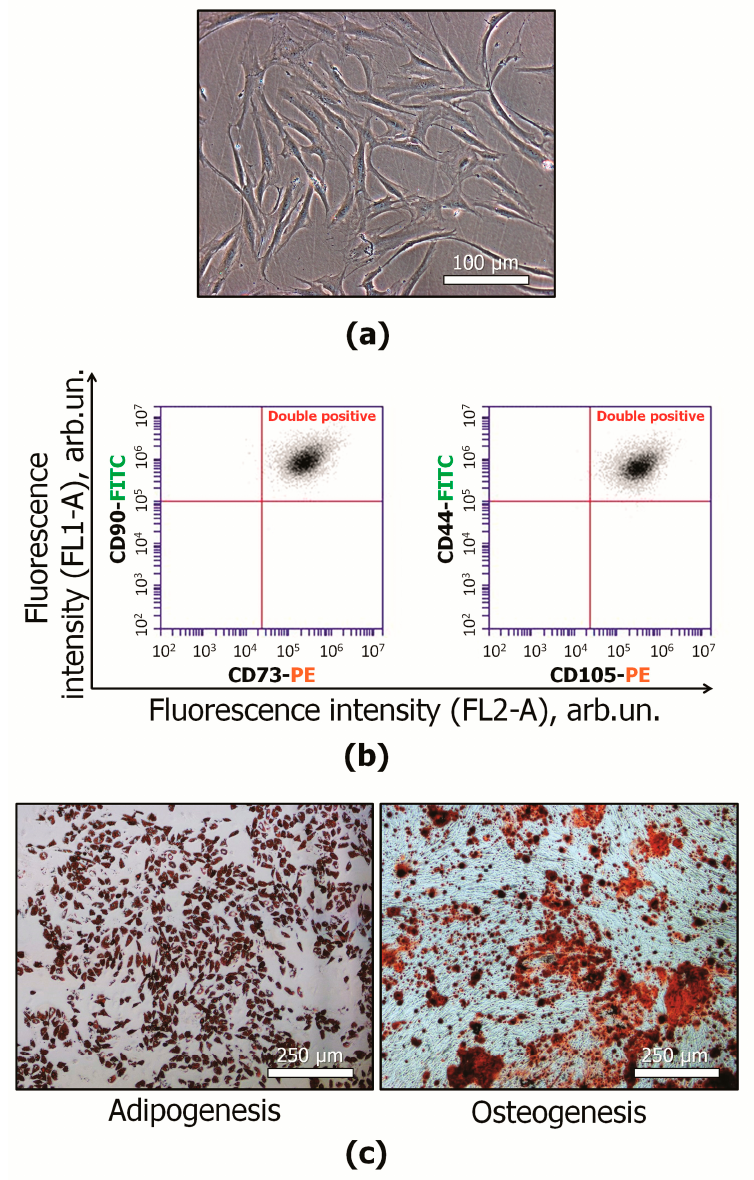
Figure 1. Characterization of MSCs: ( a ) representative image of MSCs in vitro, light microscopy (phase contrast); ( b ) representative flow cytometric plots of immunophenotype. MSCs were stained with antigen specific fluorescent antibodies: CD44-FITC, CD73-PE, CD90-FITC, CD105-PE; ( c ) confirmation of multilineage potential of MSCs, representative images, light microscopy (bright-field). MSCs cultured in adipogenic differentiation medium were stained with oil red O. MSCs cultured in osteogenic differentiation medium were stained with alizarin red S. MSCs—mesenchymal stromal cells; FITC—fluorescein isothiocyanate;